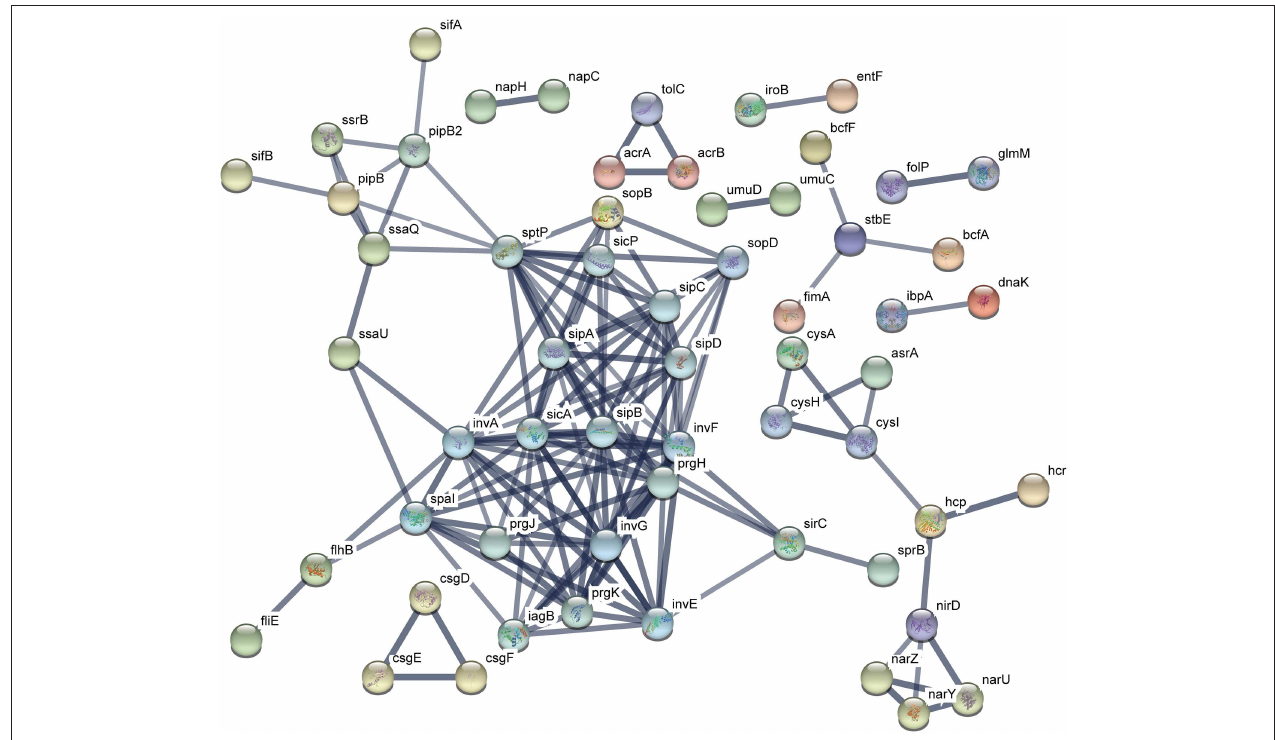
FIGURE 6 | Functional protein association networks of chromosomal DEGs after acquiring pHXY0908. Each node is a protein. Each edge represents protein-protein associations. The thicker edges indicate higher levels of confidence.